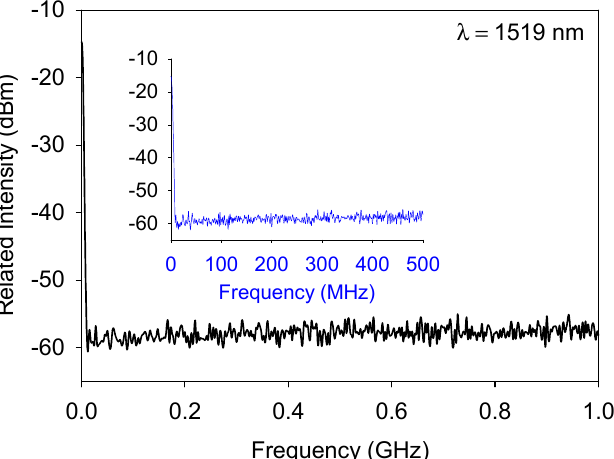
Figure 7. Measured electrical spectrum at the wavelength of 1519.0 nm within the frequency scope of 1 GHz for SLM exhibition. Inset is the measured spectrum from 0 to 500 MHz.